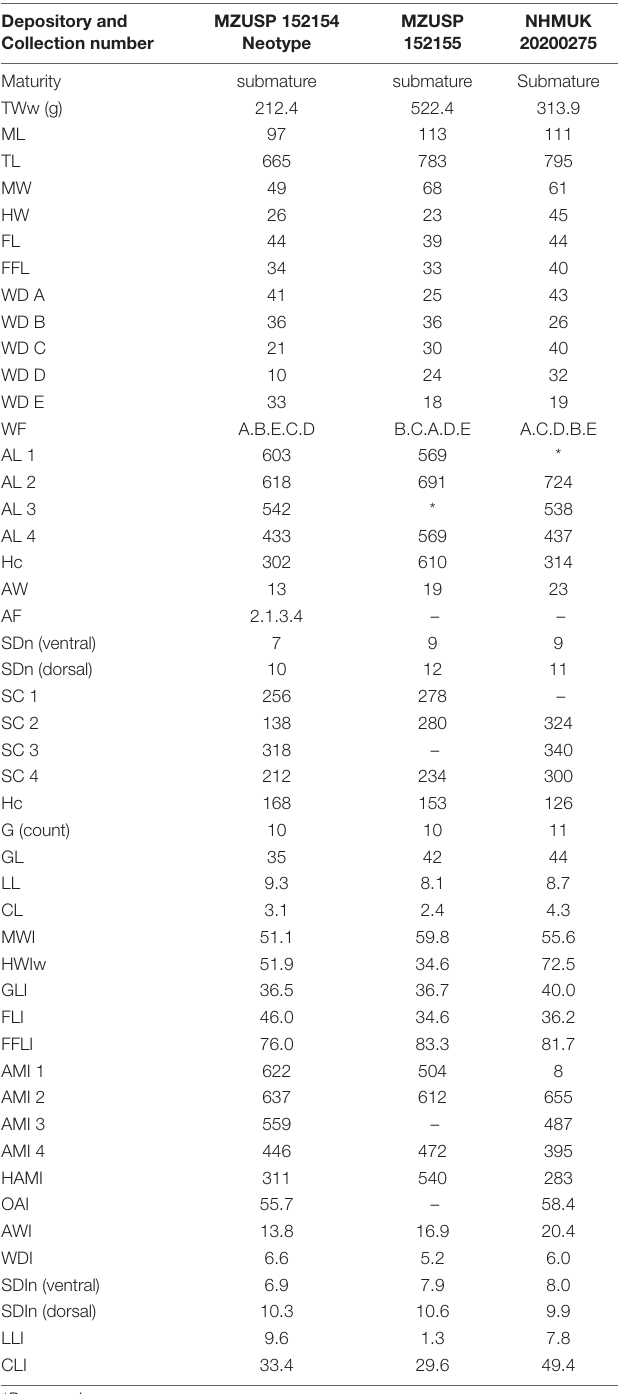
TABLE 3 | Callistoctopus furvus measurements (mm), counts and indices for preserved males (neotype and voucher specimens). Depository and Collection